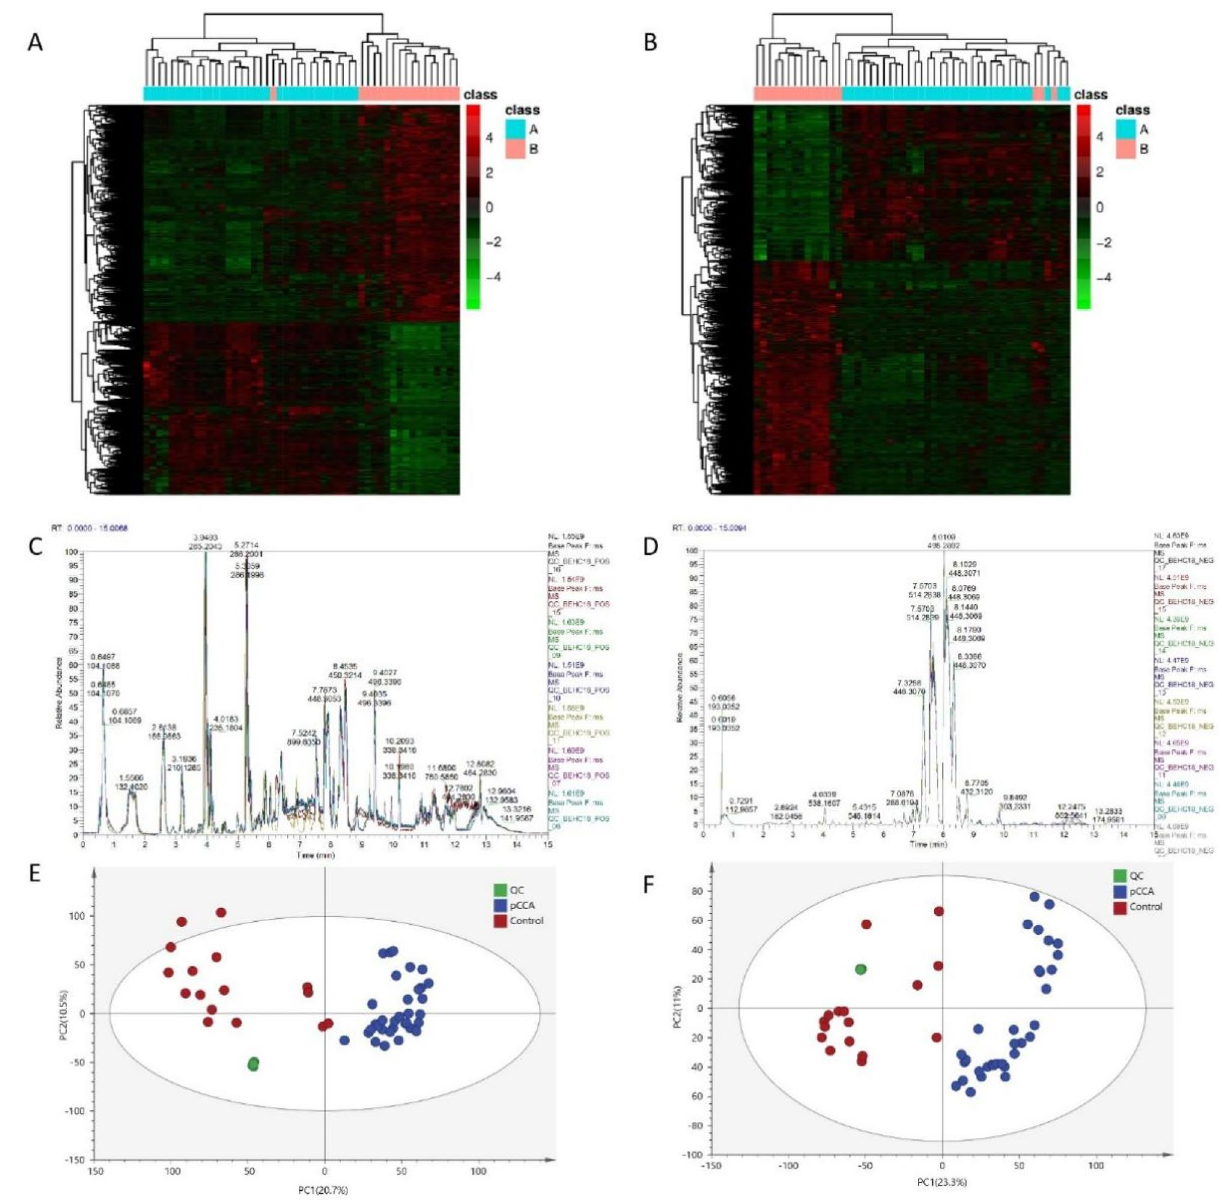
Figure 1. Cluster analysis of differential metabolites. The heatmap of POS ( A ) and NEG ( B ) models. Each row represents a differential metabolite, each column represents a sample, color represents expression levels, green to red corresponding expression levels from low to high (A = pCCA group, n = 33; B = control group, n = 16). The BPC of POS ( C ) and NEG ( D ) models for QC samples. The BPC obtained by continuously delineating the intensity of the strongest ion in the mass spectrum at each time point. The BPCs of all QC samples were overlaid. The spectra overlap well. The fluctuation of retention time and peak response strength was small, indicating that the instrument was in good condition and the signal was stable during the whole sample detection and analysis process. The PCA score map for all samples, in POS ( E ) and NEG ( F ) models. The abscissa is the first principal component PC1, the ordinate is the second principal component PC2, and the ellipse is the 95% confidence interval. Each point represents a sample and the color represents a different group. Numbers in parentheses are the scores for the principal component and represent the percentage of the population variance interpreted by the corresponding principal component (PCCA group, n = 33; Control group, n =